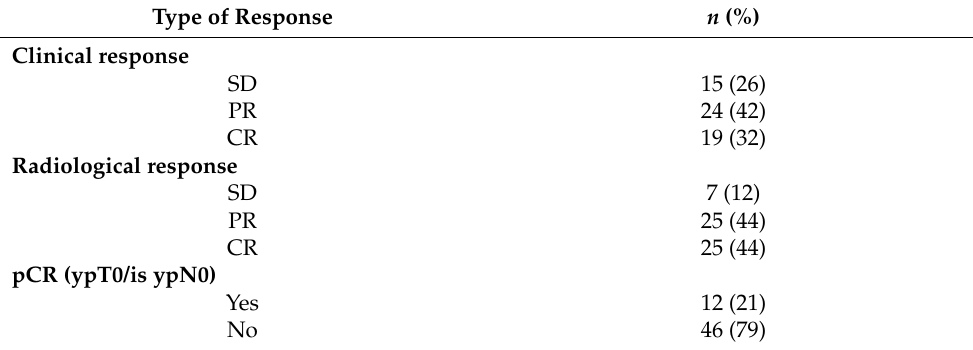
Table 2. Response assessment after neoadjuvant treatment.